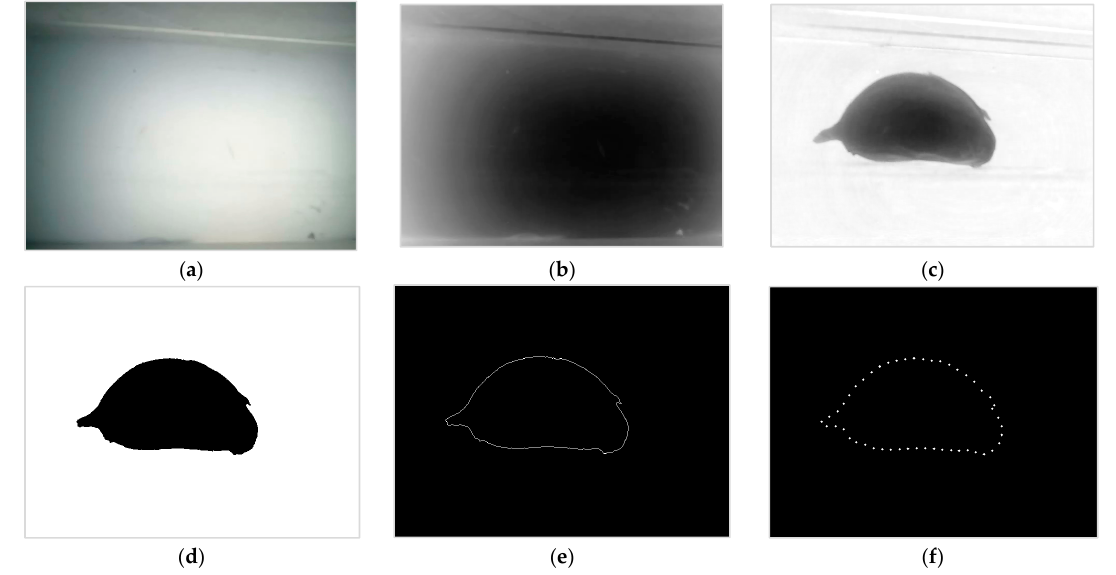
Figure 3. Contour extraction after pixel compensation. ( a ) Background of conveyor, no clove, ( b ) Pixel compensation matrix, ( c ) Compensated garlic clove shadow, ( d ) Binary shadow image, ( e ) Outline of garlic seed, ( f ) Contour sampling points.